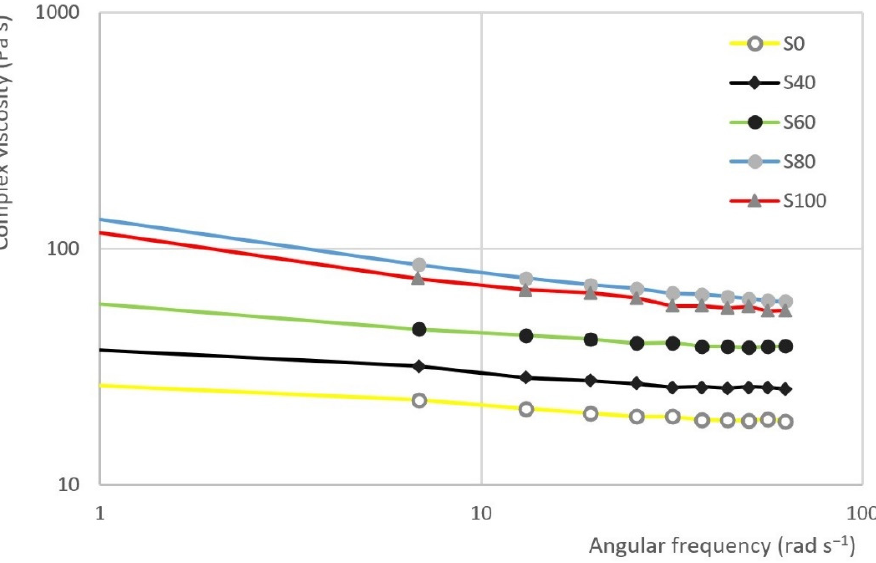
Figure 9. The dependence of the complex viscosity ( η ∗ ) on the angular frequency in the selected samples.